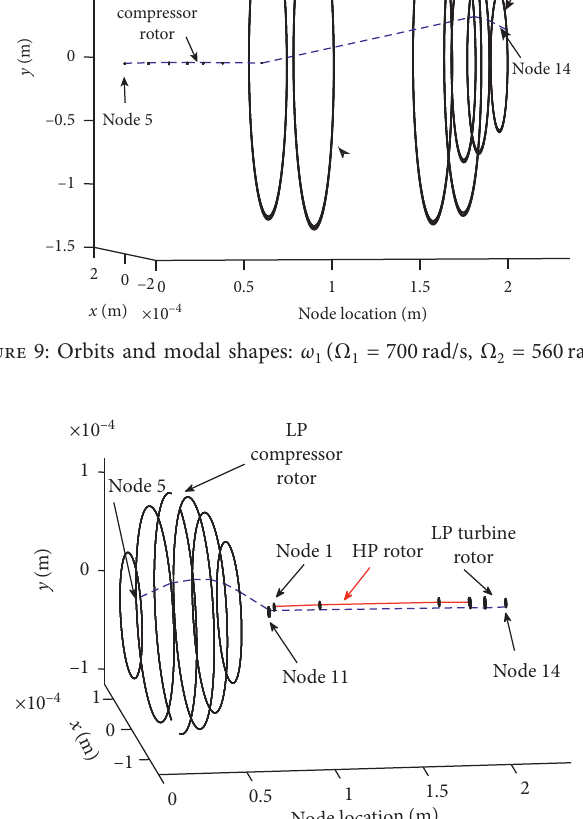
( Ω � 1640rad/s , Ω 2 1